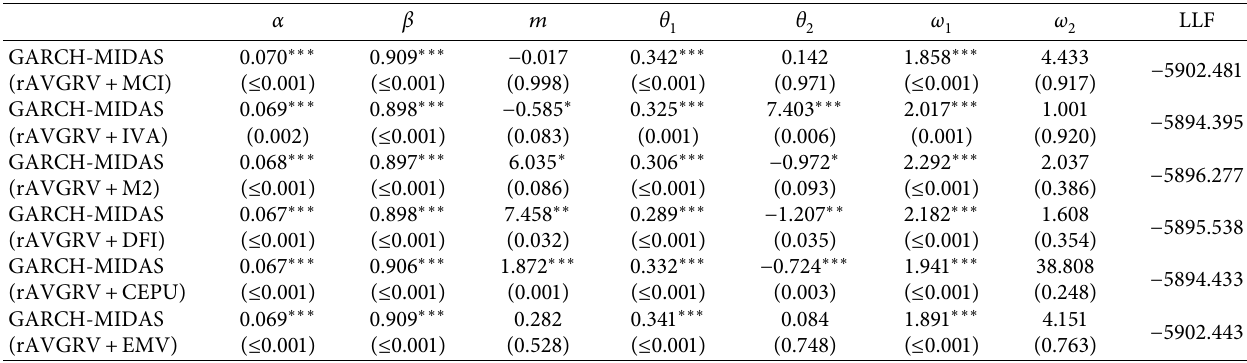
Table 3: Estimation results of multifactor GARCH-MIDAS model ( K �